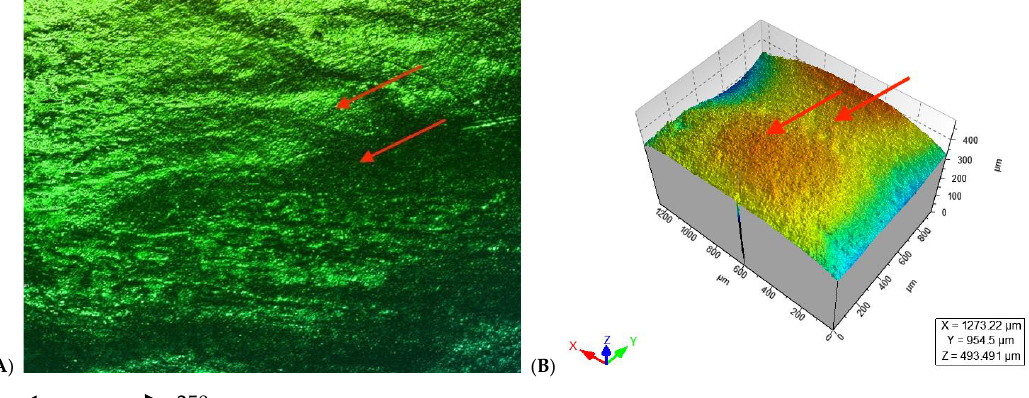
Figure 4. ( A ) Enamel appearance on confocal microscopy after debonding and polishing with a white stone bur high-speed handpiece (arrows point at the more representative indentations of the enamel surface); ( B ) 3D scheme of surface roughness of the selected representative sample for Group 1 (arrows point at the same area on the representative 3D model of the image’s roughness).